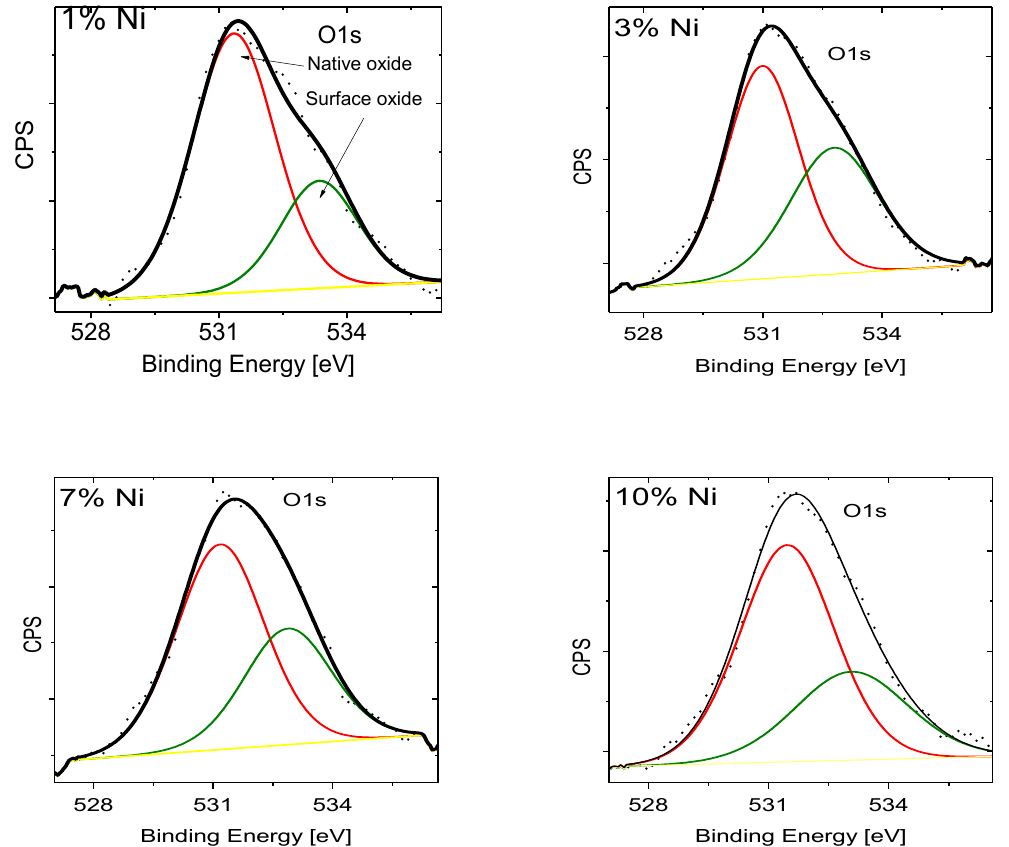
Figure 8. High-resolution XPS spectra are plotted for the Ni 2p photoelectrons. XPS is recorded for the ZnNiO samples containing 1%, 3%, 7% and 10% Ni weight percentages. show relatively little change in the positions 1023 eV and 1046 eV of both types of 2p electrons of Zn + ion. The Zn 2 oxidation state remains invariant to the doping.